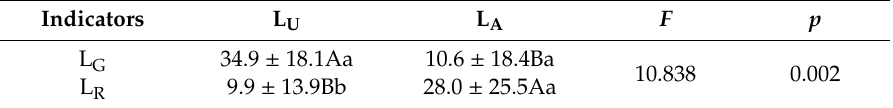
Table 4. Spatial distribution characteristics two-way analysis